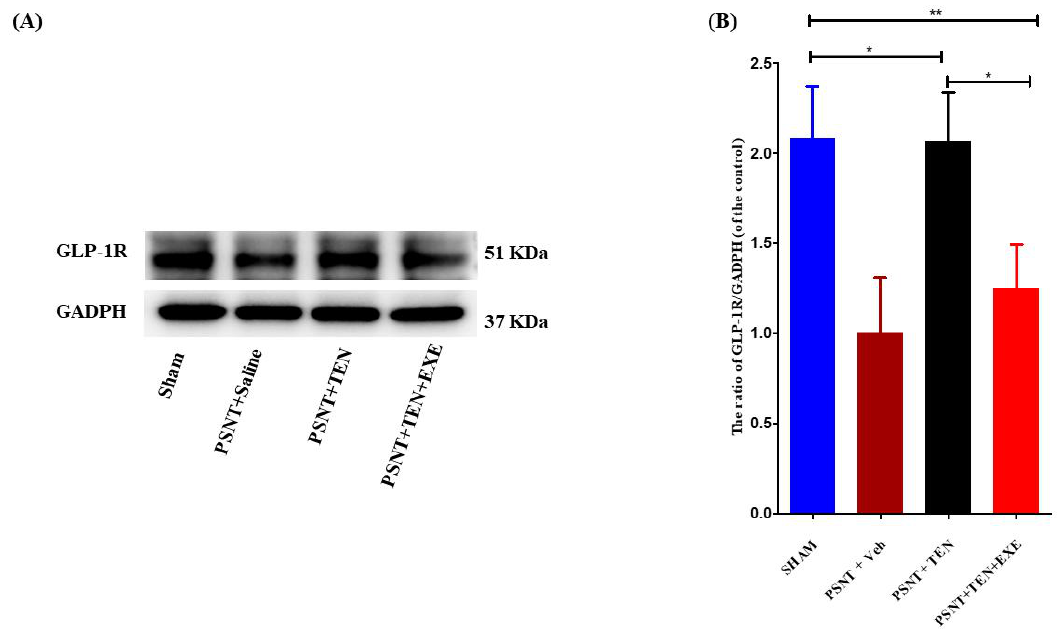
Figure 3. The expression and activation of GLP-1R by TEN. ( A ) Western blot and ( B ) The quantitative analysis of GLP-1R in sham and PSNT rat models i.t infused with vehicle (1 µL/h) or TEN (5 μg/1 μL/h) or TEN (5 μg) + EXE (0.1 μg)/1 μL/h for 7 days. Asterisk denotes a statistically significant difference between sham vs. PSNT + TEN, sham vs. PSNT + TEN + EXE and PSNT + TEN vs. PSNT + TEN + EXE. * p < 0.05; ** p < 0.01, ( n = 6 animals per group).